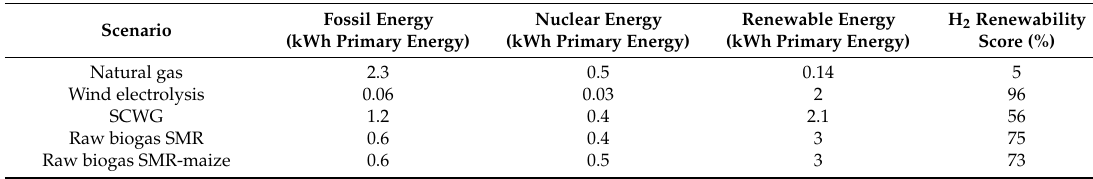
Table A1. Energy demand per kWh H2 and H 2 renewability score